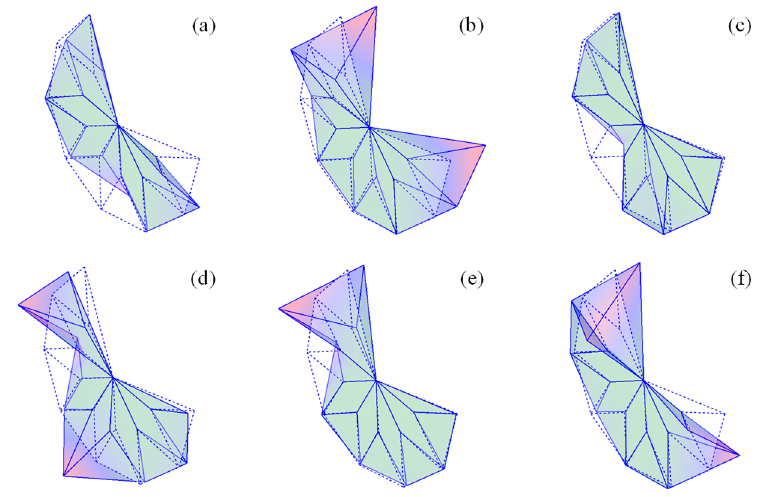
Figure 8. Mode shapes of the dust shield corresponding to natural frequencies of ( a ) 888 Hz, ( b ) 940 Hz, ( c ) 998 Hz, ( d ) 1120 Hz, ( e ) 1200 Hz, and ( f ) 1300 Hz. ( b ) 940 Hz, ( c ) 998 Hz, ( d ) 1120 Hz, ( e ) 1200 Hz, and ( f ) 1300